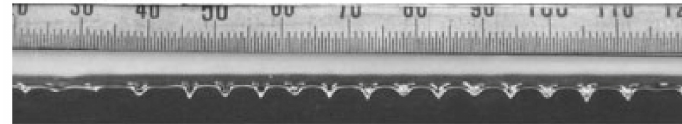
Figure 11. Melt needleless electrospinning at straight-line open free surface [16]. Reprinted with